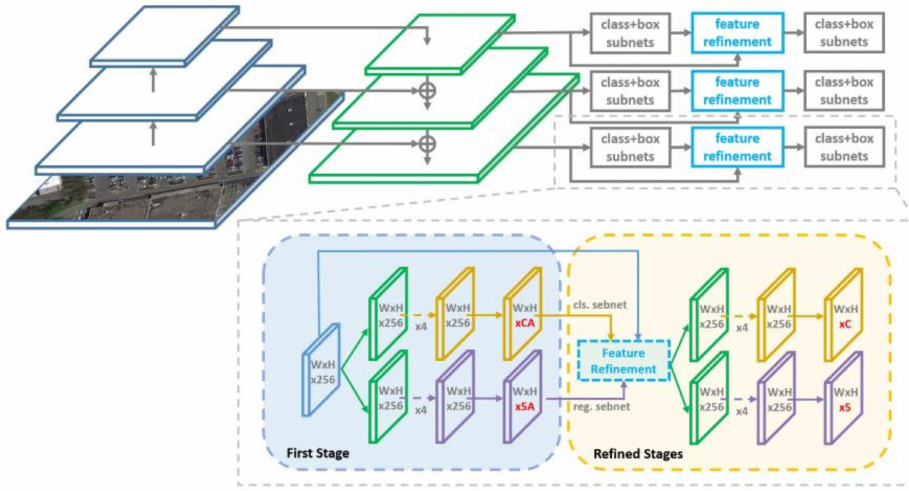
Figure 3. R3Det Overall network